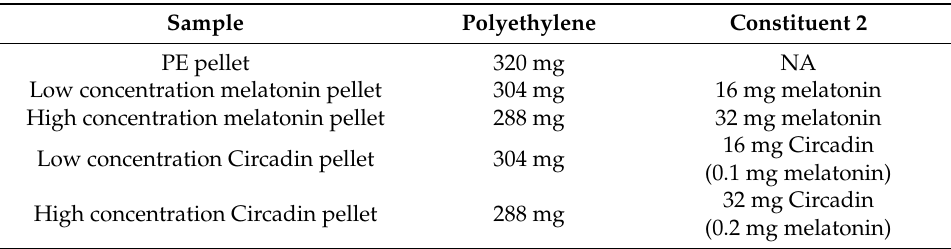
Table 1. Pellets composition for THz-TDS